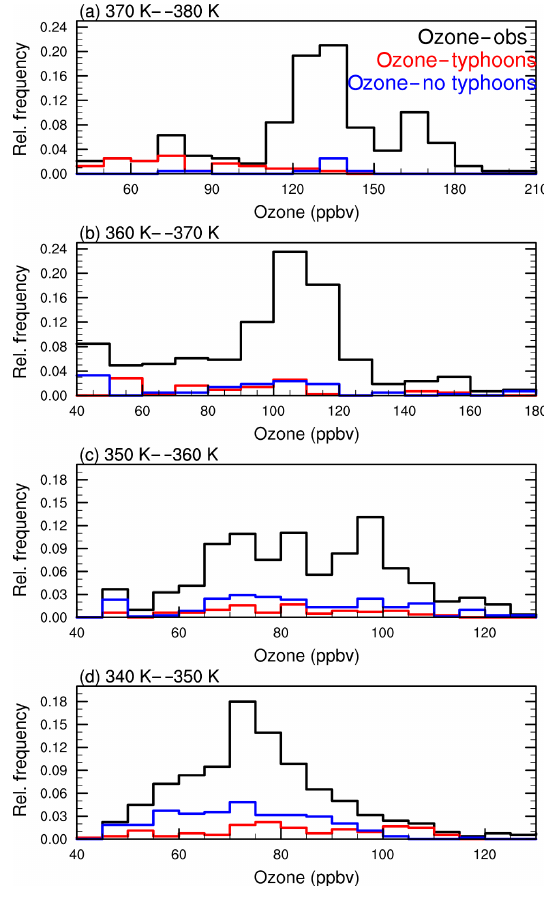
Figure 10. The relative frequency distribution of all ozone pro- files observed in August 2013 (ozone–obs, in black) and ozone with (ozone–typhoons, in red) or without (ozone–no typhoons, in blue) the influence of tropical cyclones with respect to potential temper- ature layers of (a) 370–380K, (b) 360–370K, (c) 350–360K, and (d)